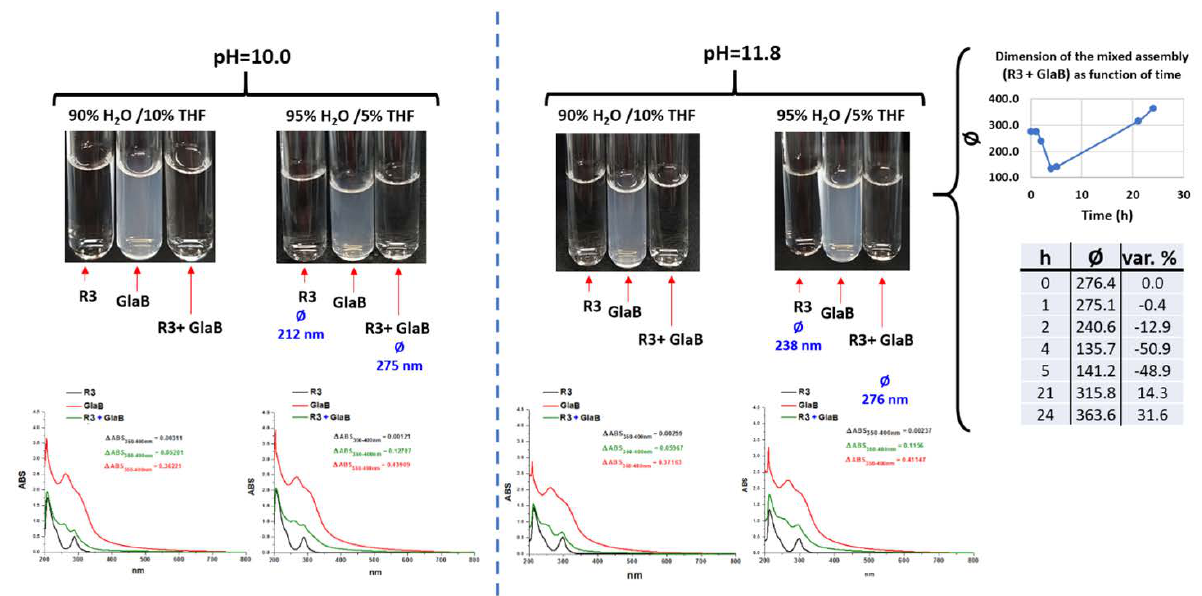
Figure 11. The ability of lyophilic colloids based on resorc[4]arene R3 to act as a molecular shuttle of GlaB by using THF/(buffer-pH 10.0 ) and THF/(buffer-pH 11.8 ) mixtures at different δ H